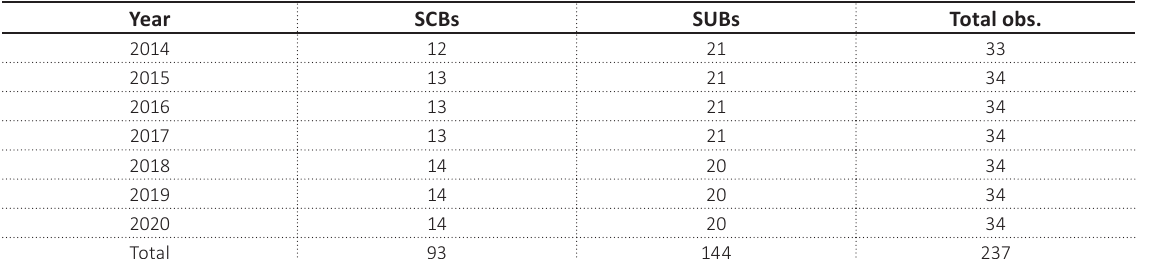
Table 1. Number of IBs and total observations